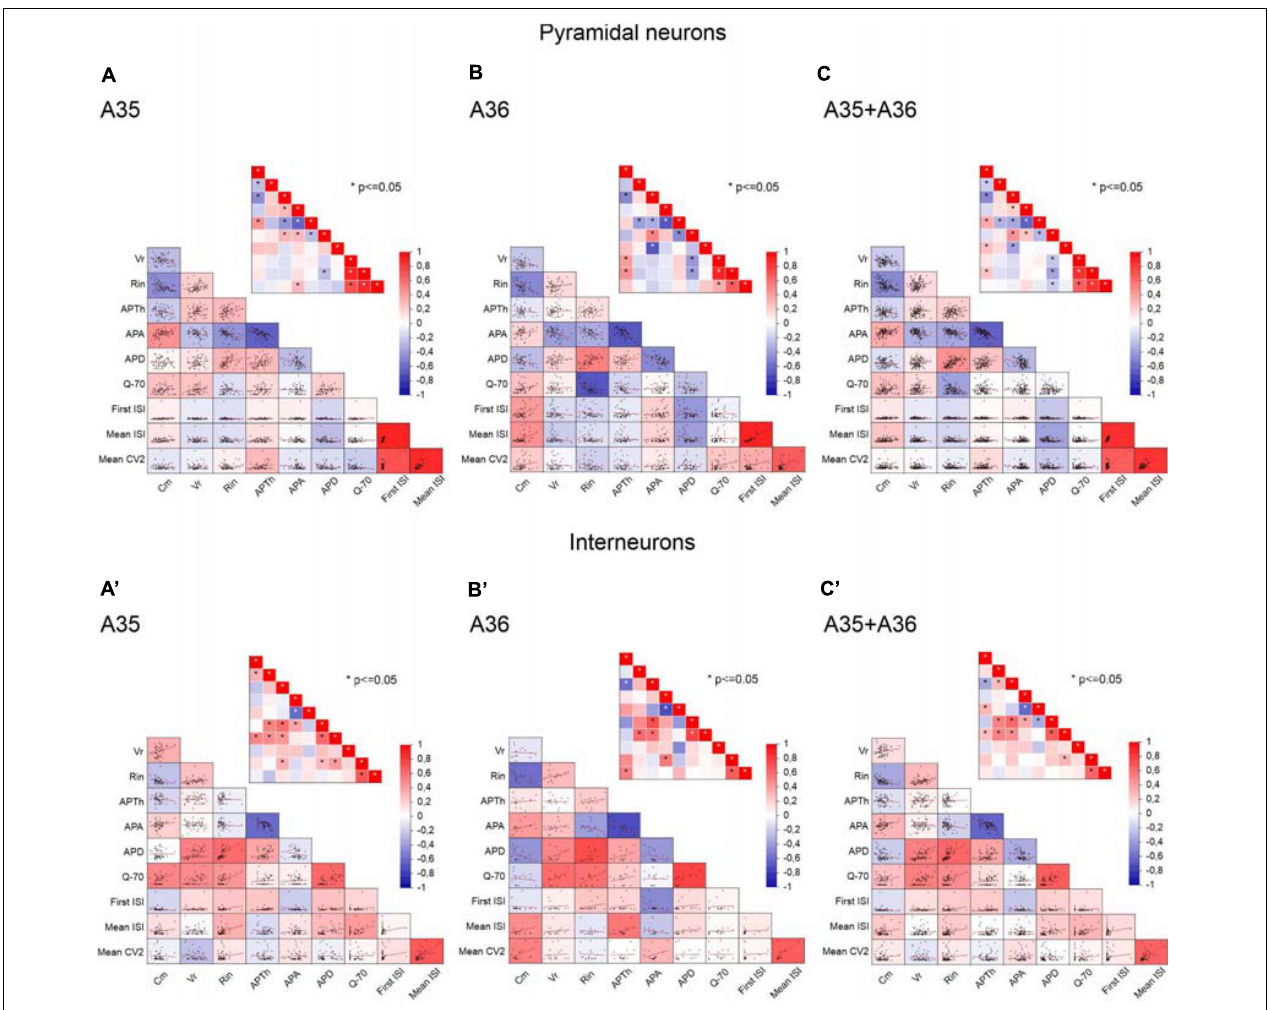
FIGURE 5 | Correlations between passive properties, firing properties, and resonance in the neurons of the different PRC areas. (A–C) Pairwise scatterplot matrices of C m (membrane capacitance), V r (membrane resting potential), R in (input resistance), AP Th (spike Threshold), AP A (spike Amplitude), AP D (spike Duration), Q - 70 , First ISI, Mean ISI, Mean CV2 of pyramidal neurons recorded from A35 (A) , A36 (B) , and both A35+A36 (C) . These scatterplot matrices are overlaid on the corresponding color-coded correlation matrices and the insets in each panel represent the significance value associated with each scatterplot, computed as Pearson’s correlation coefficients. (A (cid:48) –C (cid:48) ) Same as (A–C) for GABAergic interneurons. * p ≤